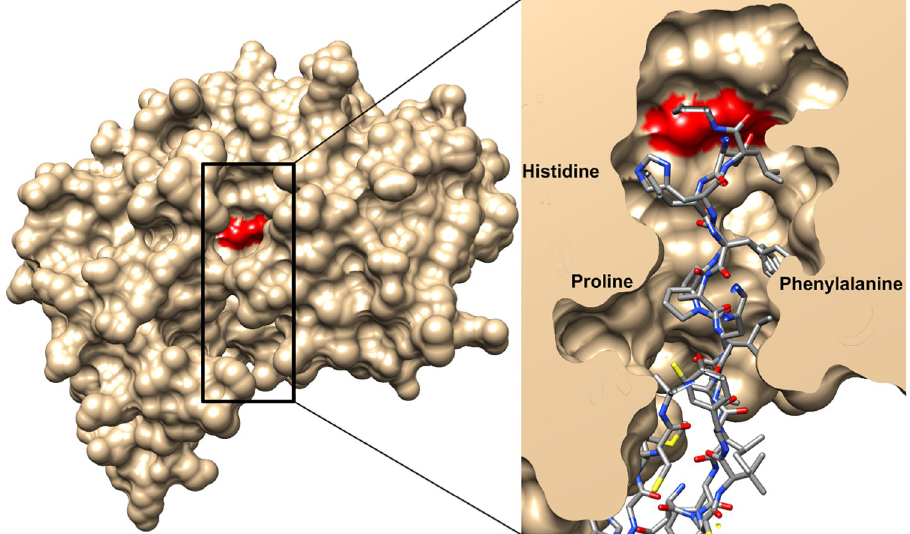
Fig 2. The molecular surface representation of human renin and its activity site. Superposition of human hepcidin and N-terminal angiotensinogen peptides and surface representations indicate common structural position of histidine, phenylalanine, and proline motifs in renin active site. This representation shows moreover, how hepcidin binding near the catalytic aspartates (in red) can cause renin inhibition.